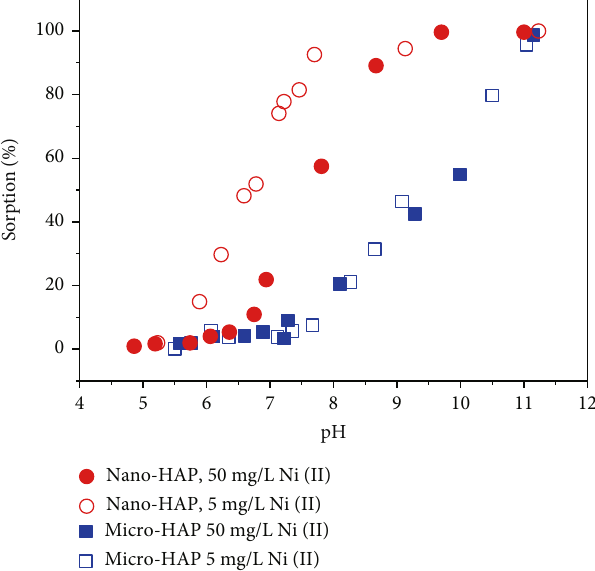
Figure 4: The in fl uence of pH on Ni(II) sorption on micro-HAP